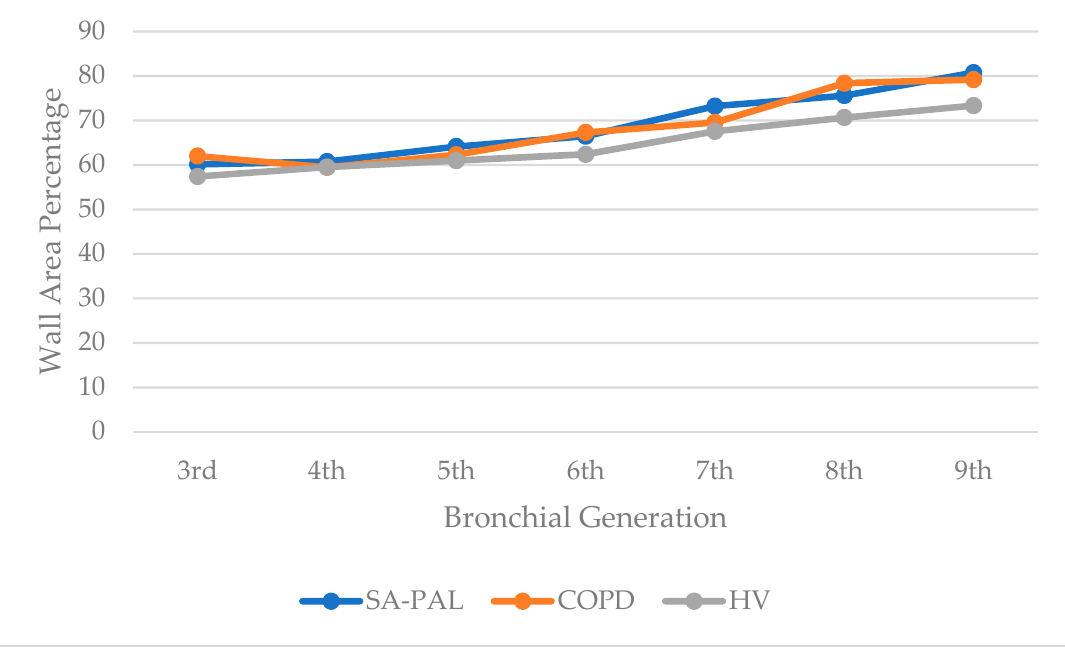
Figure 3. Wall area percentage (WA%) of the bronchial tree generations in patients in the SA-PAL, COPD, and HV groups.